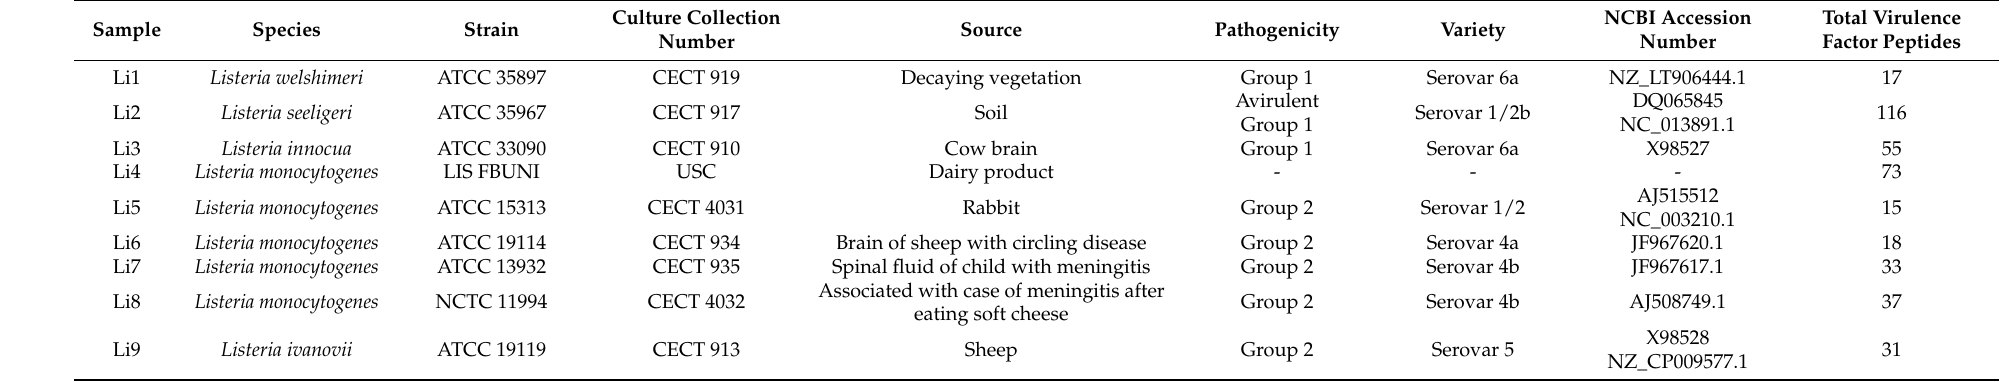
Table 1. Listeria strains used in this study. Total virulence factor peptides represent the number of peptides identified by LC–ESI-MS/MS. Pathogenicity data corresponds to the risk group of each analyzed strain. ATCC—American Type Culture Collection; CECT—Spanish Type Culture Collection; NCTC—The National Collection of Type Cultures of Public Health